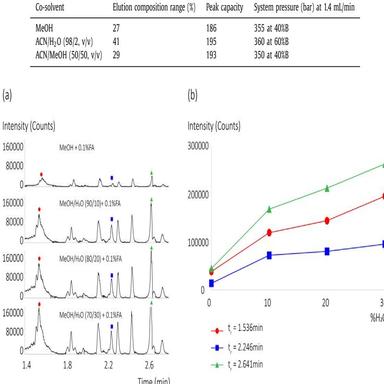
Effect of the addition of water in the make-up solvent. (a) Sum of 5 EICs (m/z 223.181, 270.280, 278.248, 284.295, and 317.102) with different amount of water in the make-up solvent. (b) Peak intensity (retention times of 1.536, 2.246 and 2.641 min in Fig. 3a) versus percentage of water in the make-up solvent.